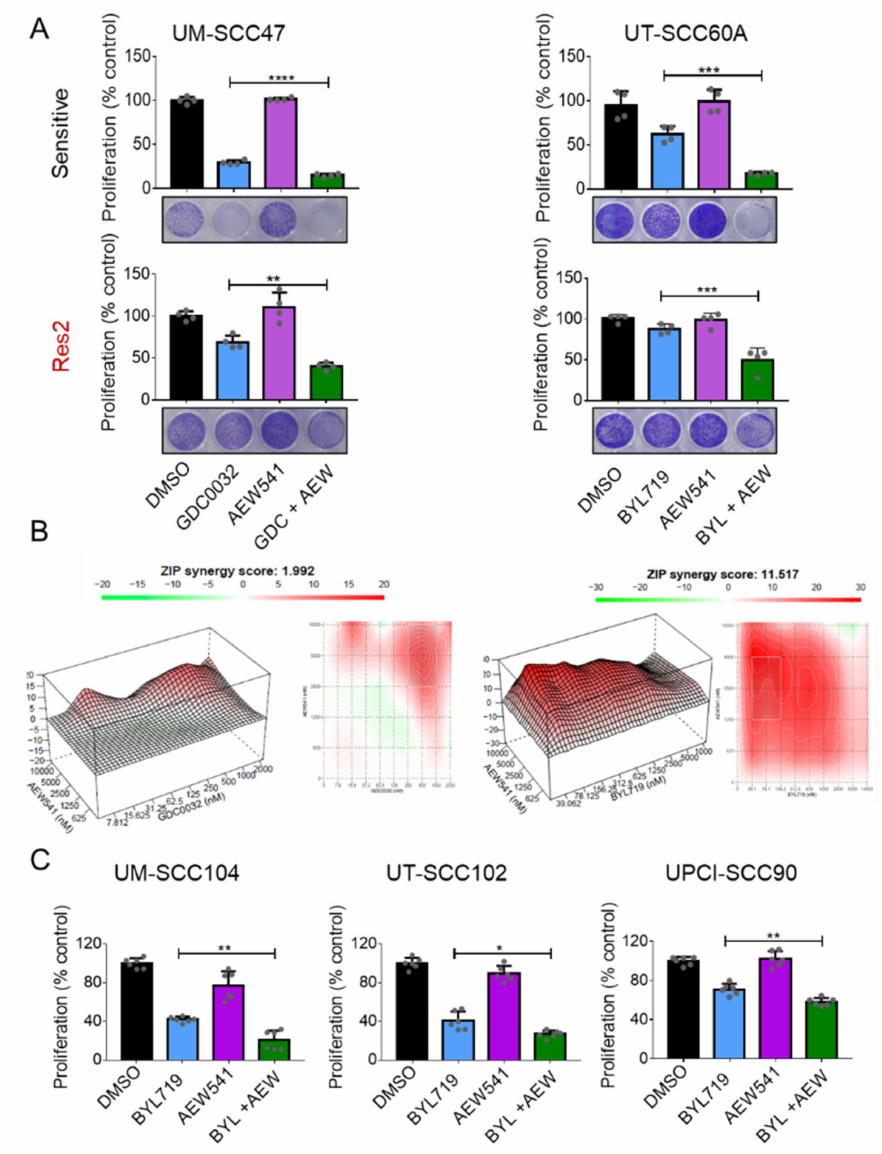
Figure 4. IGF1R inhibition synergizes with isiPI3K in inhibiting the viability of HNC HPV+ cells. ( A ) UM-SCC47 and UT- SCC60A sensitive and acquired resistance cells (Res2) were cultured with DMSO, GDC0032 (500 nM) or BYL719 (2 µ M), AEW541 (1 µ M), or a combination of AEW541 with GDC0032 or BYL719. Four days post-treatment, cell viability was determined using crystal violet staining. The proliferation experiment was repeated 3 times, and representative results from one experiment are presented. Biological replicates from one experiment are shown as grey dots. ( B ) ZIP model synergy test was performed in both UM-SCC47 and UT-SCC60A cell lines. Cells were cultured with increasing concentrations of GDC0032 (0 up to 2 µ M) or BYL719 (0 up to 10 µ M) and AEW541 (0 up to 10 µ M). Four days post-treatment cell viability was determined using crystal violet stanning. The results are presented as a ZIP synergy score with 3-D surface plots displaying synergy regions (left panel) along with a dose-response matrix (right panel). The synergy experiment was repeated 3 times, and representative results from one experiment are presented. ( C ) UM-SCC104, UT-SCC102, and UPCI-SCC90 sensitive cells were cultured with DMSO, BYL719 (2 µ M), AEW541 (1 µ M), or a combination of the two drugs. Four days post-treatment cell viability was determined using crystal violet staining. The proliferation experiment was repeated 3 times, and the results of one representative experiment are presented as means ± SEM. Biological replicates from one experiment are shown as grey dots. Statistical significance was calculated by one-way ANOVA, * p < 0.05; ** p < 0.01; *** p < 0.001; **** p <